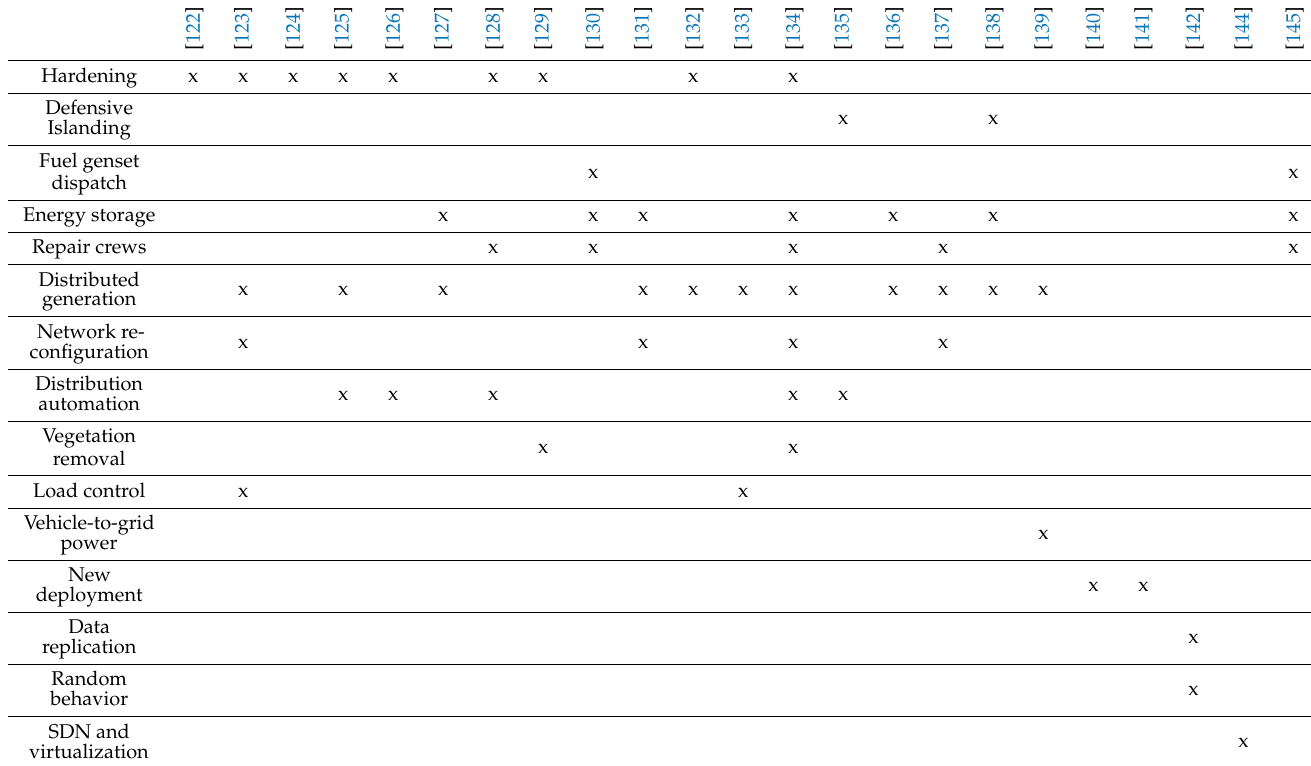
Table 3. Resilience enhancement